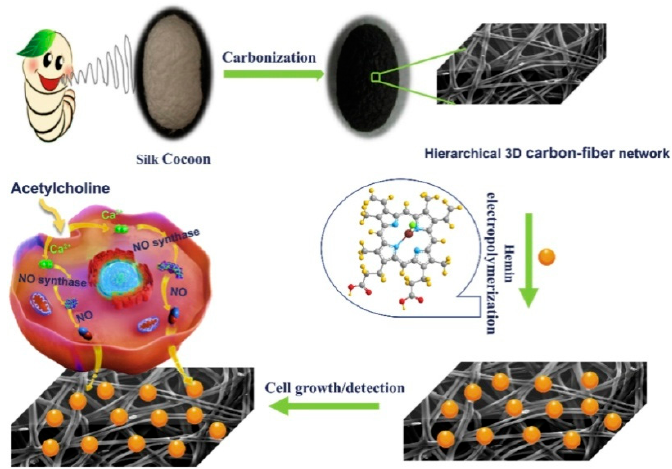
Figure 12. Illustration of preparation of the 3D hemin/CFN matrix and its cell adhesive and sensing application. Reprinted with permission from [53]. Copyright 2021 Elsevier.